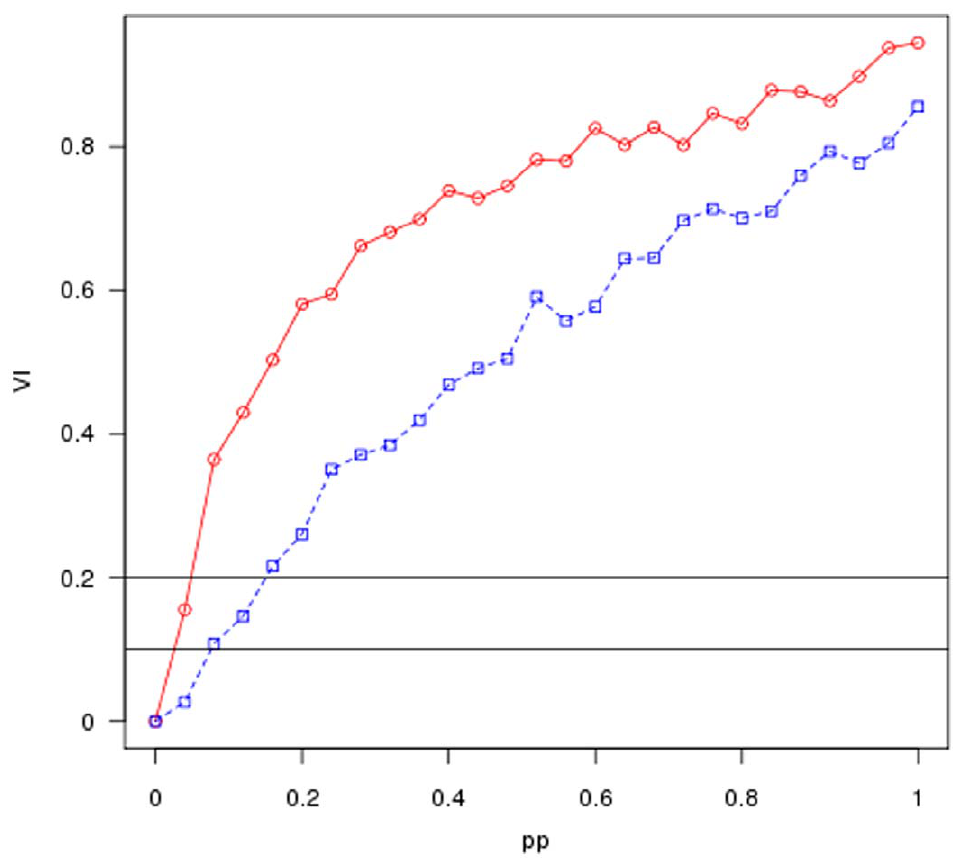
Figure 3. Average results of the application of our stability analysis to the real finacial data example. The average value of the normalized variation of information is plotted as a function of the amount of perturbation pp . The black points in the figures show the variation of information for the unperturbed financial network while the red points show the results for the correspondent random graph (null model).